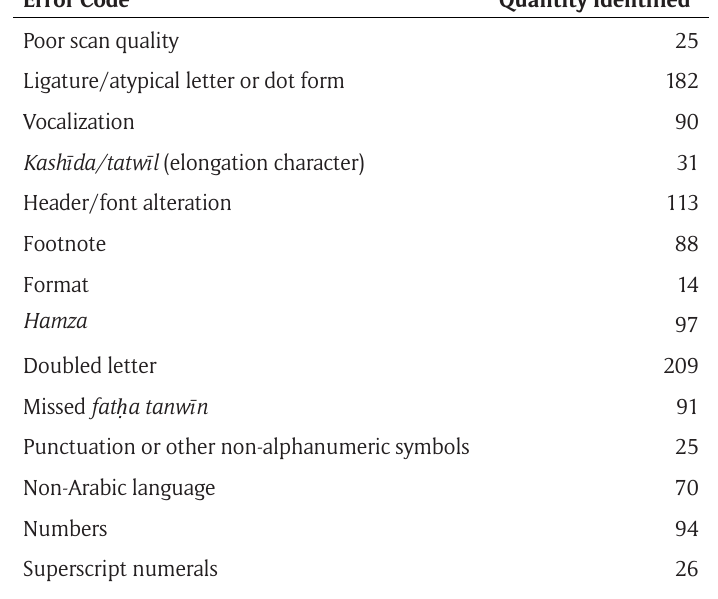
Table 3 : Error coding for error instances in OpenITI manual OCR output